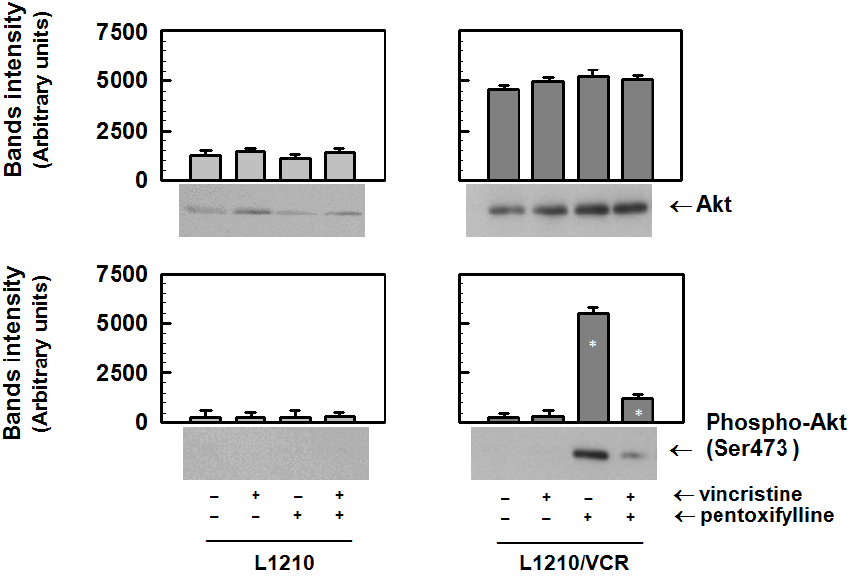
Figure 4. Effect of VCR and PTX treatment on Akt kinase protein expression and specific phosphorylation. The sensitive L1210 and resistant L1210/VCR cells were treated with 100 μmol/L PTX and/or 1.2 μmol/L VCR for 24 h, Akt kinase protein expression and its specific fosforylation (on Ser 473) were determined by Western blot analysis using a specific antibodies. Blots of three independent experiments were quantified and obtained data were evaluated by Student’s t test. * Different from control (without drugs) at significance level p <